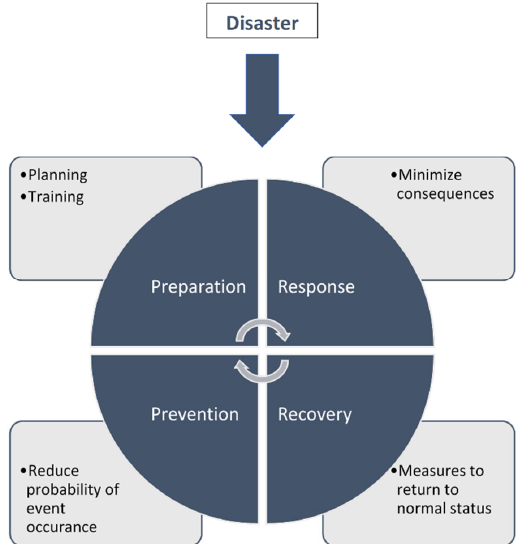
Figure 1. Four disaster management phases (Prevention, Preparation, Response, Recovery).